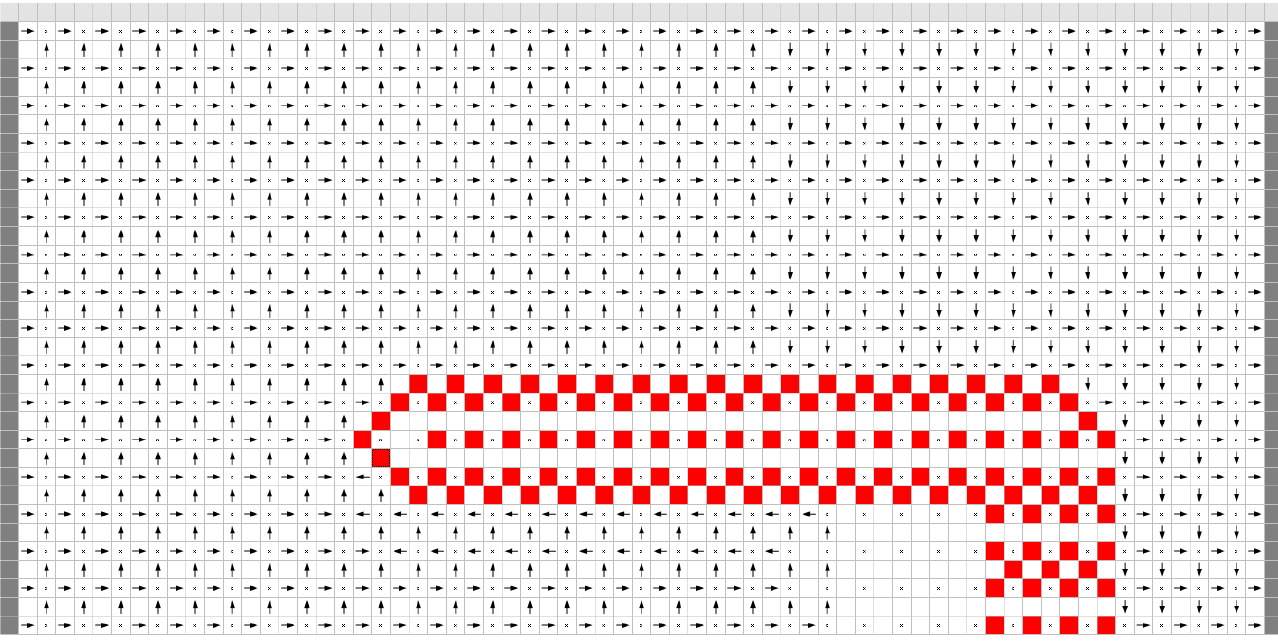
Figure 11. Initial distribution of currents over the ERs.